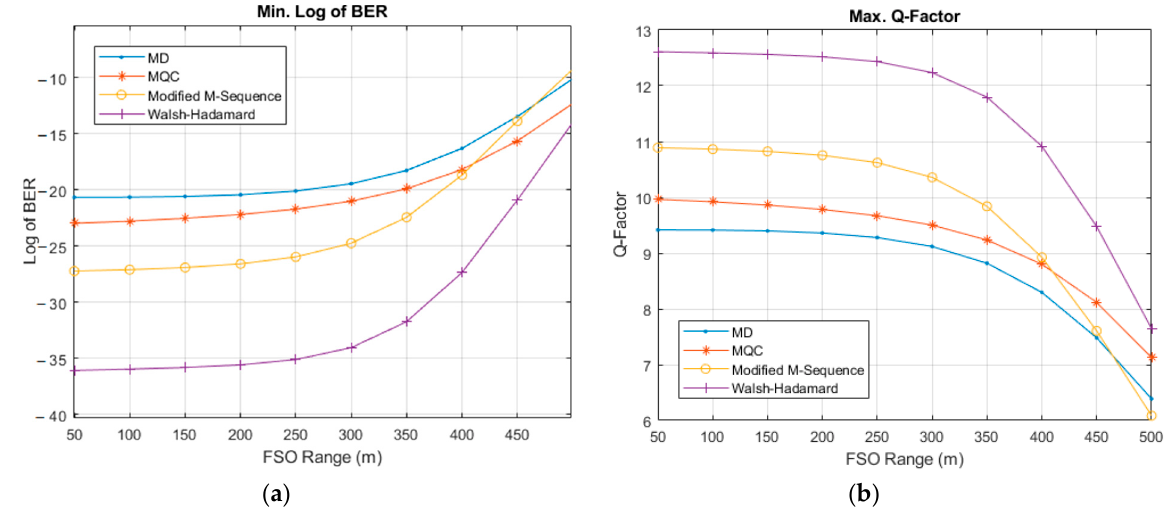
Figure 12. Performance of the system in intense rainy weather condition for AWGN and turbulence ‐ induced fading chan ‐ nel: ( a ). min. log of BER; ( b ). max. Q ‐ factor.